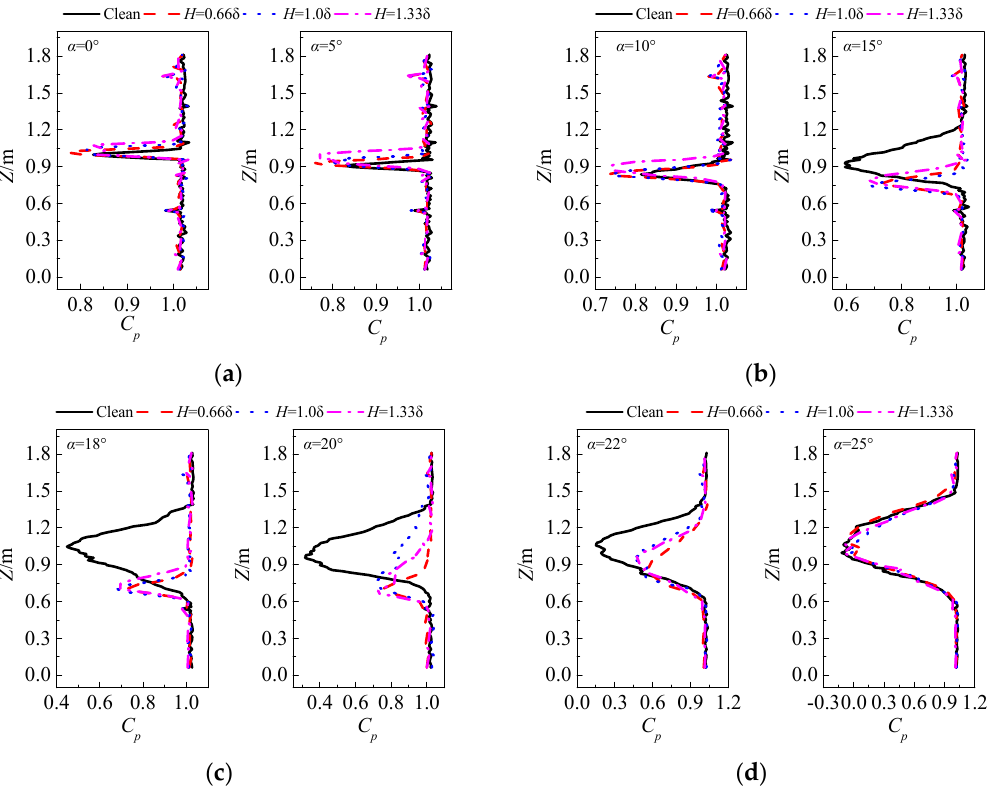
Figure 20. Distribution of total pressure coefficient at the wake rake. ( a ) α = 0°; 5°, ( b ) α = 10°; 15°, ( c ) α = 18°; 20°, ( d ) α = 22°; 25°.